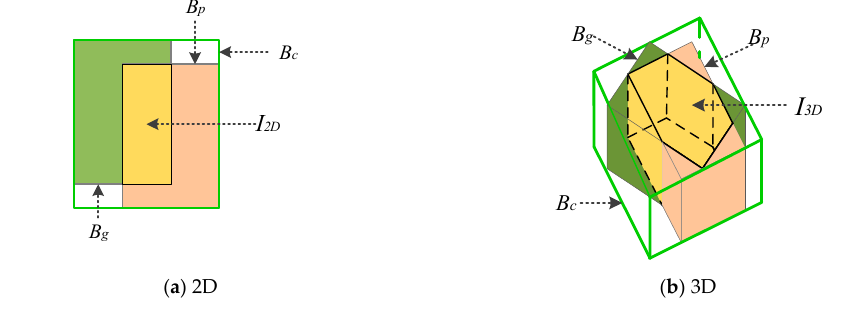
Figure 5. Different ways of overlap between bounding boxes in case of 2D and 3D, respectively. For ( a ) and ( b ), cyan and pink represent the predicted bounding box B p and ground truth B g , respectively, and yellow represents the intersection of them. In addition, the green bounding box represents the smallest enclosing box B c